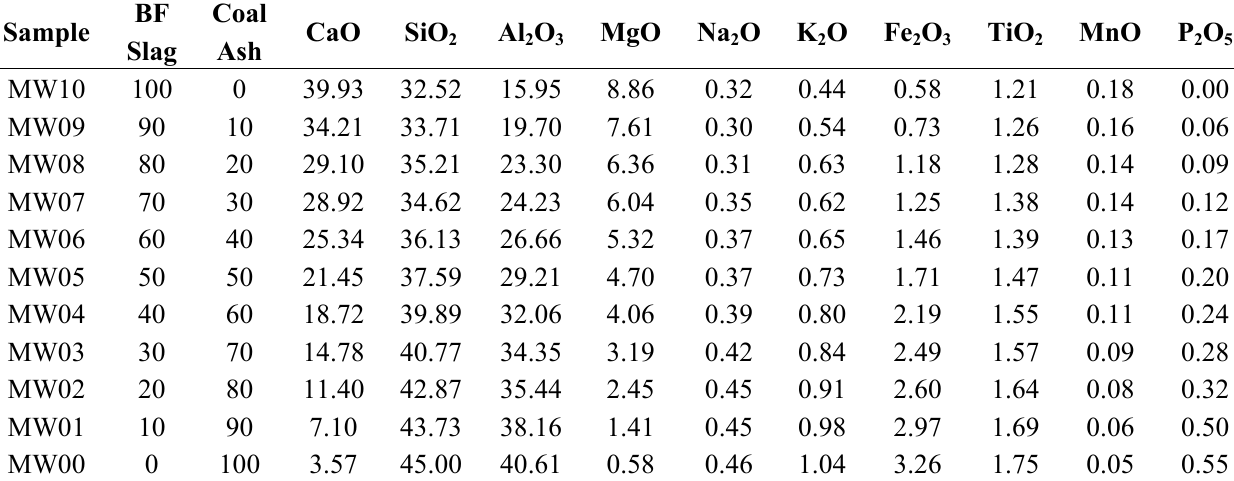
Table 1. Sample group and composition (wt